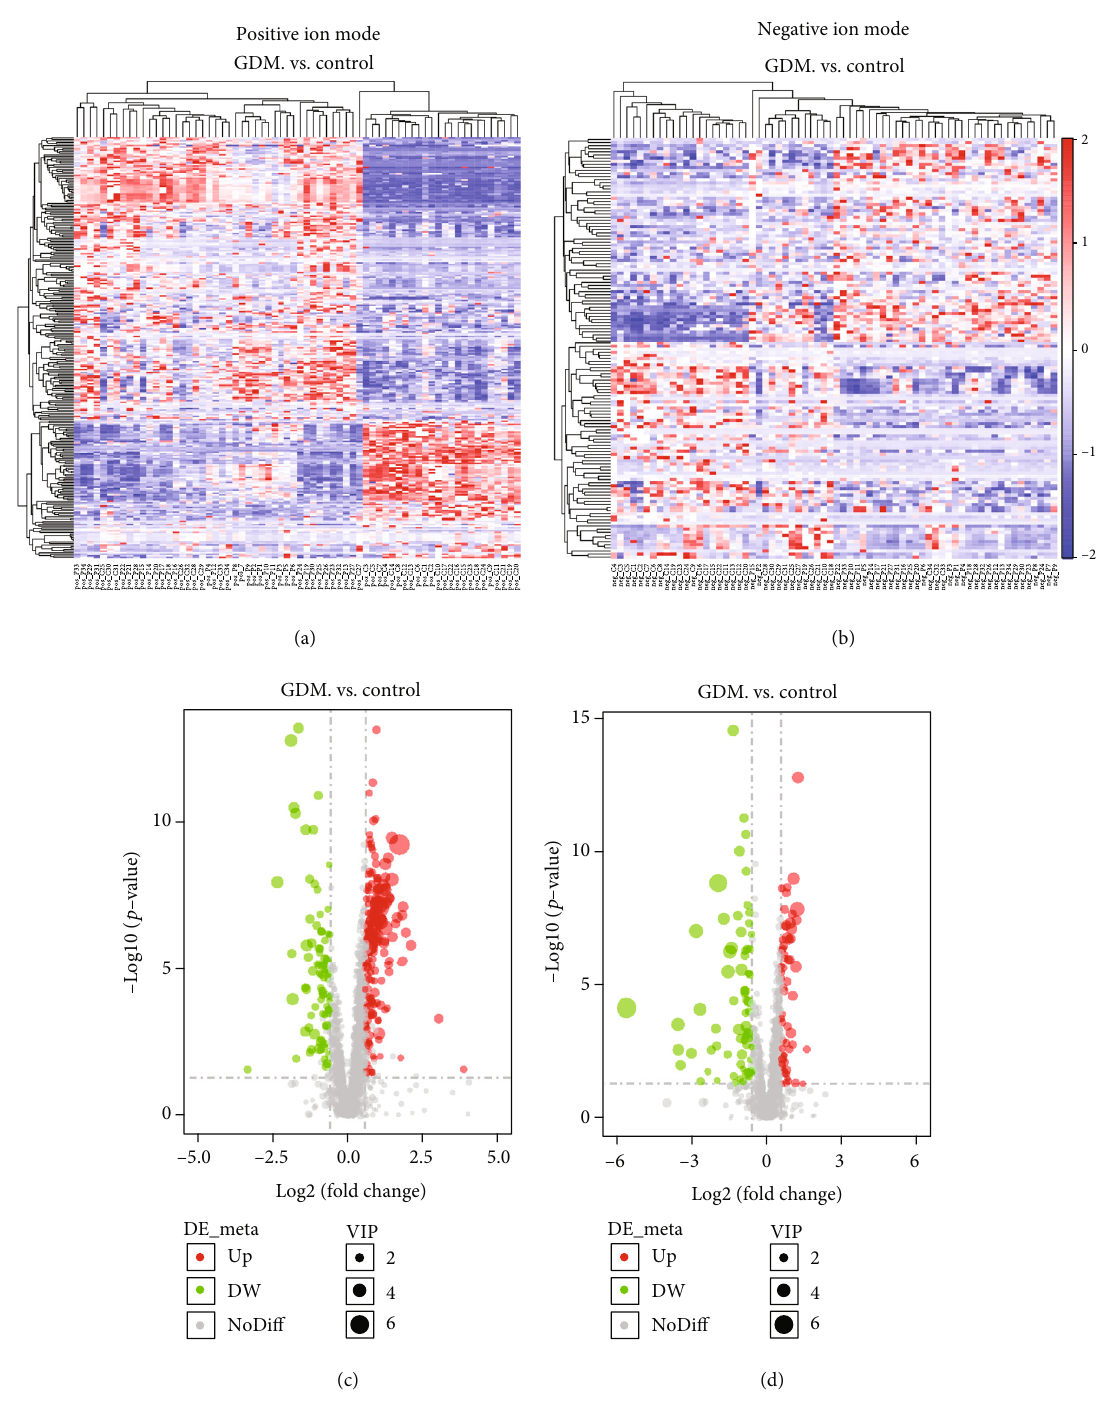
Figure 2: Analysis of di ff erential metabolites between control and GDM through LC-MS. (a, b) Hierarchical clustering analysis was performed on each group of di ff erential metabolites obtained, and the relative quantitative values of the di ff erential metabolites were converted into z values ( z = ð x – μ Þ / σ : x is a speci fi c fraction, μ is average Number, and σ is the standard deviation) and clustering; di ff erent color regions represent di ff erent clustering group information, similar to the metabolic expression patterns in the same group, and may have similar functions or participate in the same biological process. (c, d) For each metabolite di ff erence multiple, take the logarithm of 2 as the base, and take the p -value to the absolute value of the logarithm of 10 to make the volcano map. (a, c) Positive ion mode. (b, d) Negative ion